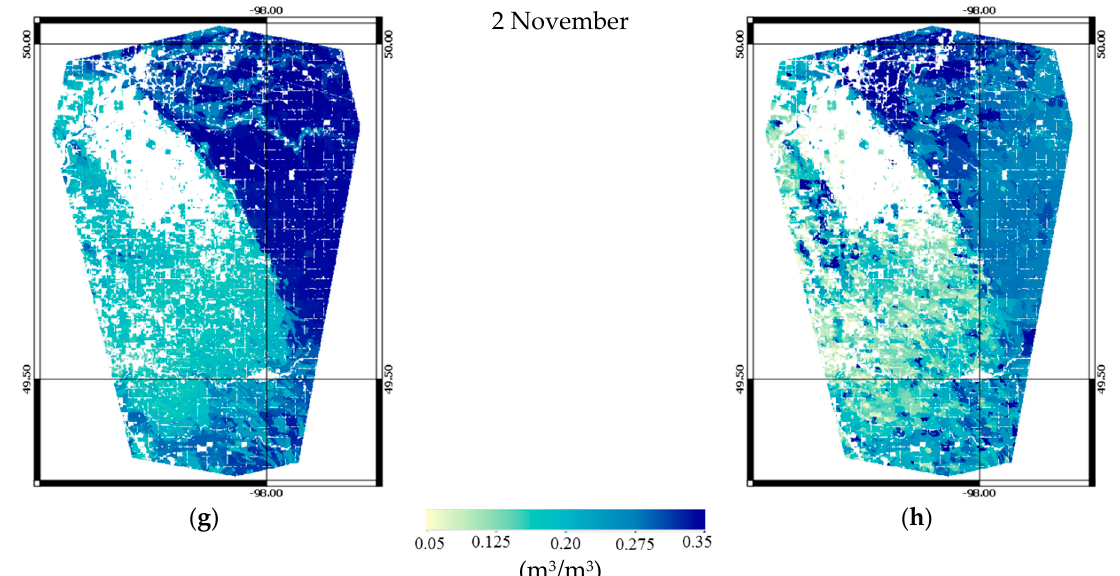
Figure 7. Resulting averaged soil moisture maps using ( a ) the SVS land surface model on September 25th, ( b ) SAR imagery on 25 September, ( c ) the SVS land surface model on 9 October, ( d ) SAR imagery on 9 October, ( e ) the SVS land surface model on 19 October, ( f ) SAR imagery on 19 October, ( g ) the SVS land surface model on 2 November, and ( h ) SAR imagery on 2 November. Averaging was conducted based on the soil texture polygons.